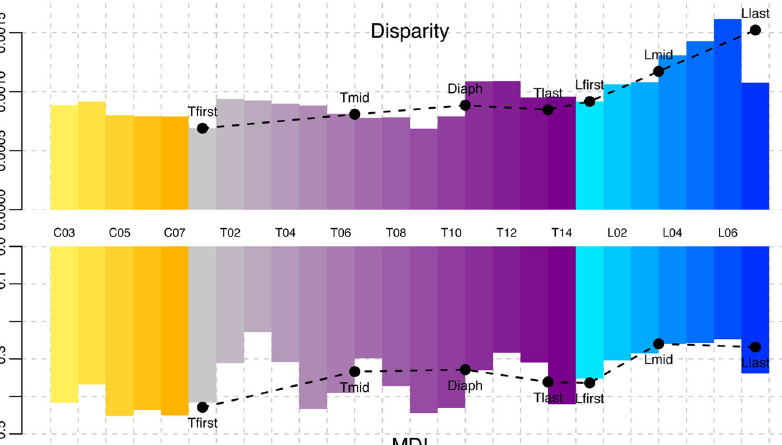
Fig. 3 Disparity analyses. The upper histogram shows the disparity values for each vertebra among-species grouping vertebrae by number. The lower histogram shows morphological disparity index (MDI) for each vertebra grouping vertebrae by number. Points in both histograms indicate disparity and MDI values obtained using a selected set of vertebrae by position: T fi rst, fi rst thoracic; Tmid, intermediate thoracic; Diaph, diaphragmatic vertebra; Tlast, last thoracic; L fi rst, fi rst lumbar; Lmid, intermediate lumbar; Llast, last lumbar. The values for the cervicals are identical for both sampling schemes, as they do not differ in count across species. Along the x -axis, they are located close to their most frequent